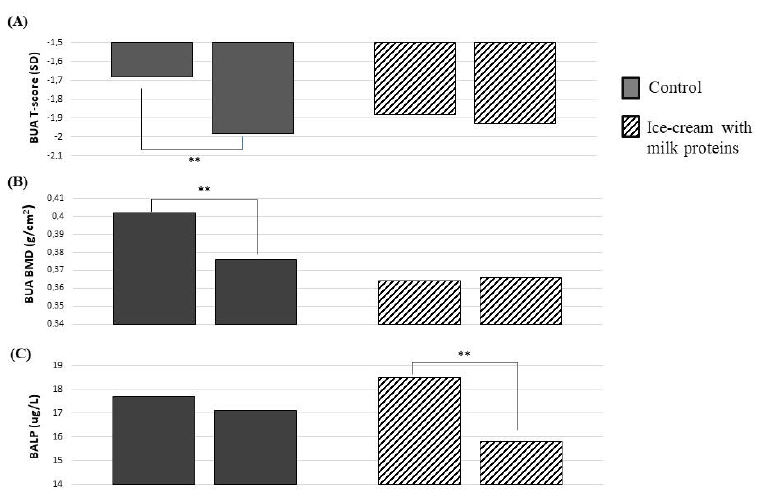
Figure 1. Changes in bone parameters after 3 months with or without milk protein-enriched ice cream. T-Score ( A ), BMD ( B ), and BAP ( C ). Abbreviations: BMD = bone mineral density; BALP = bone alkaline phosphatase. Paired Student’s t-test: ** p < 0.01.